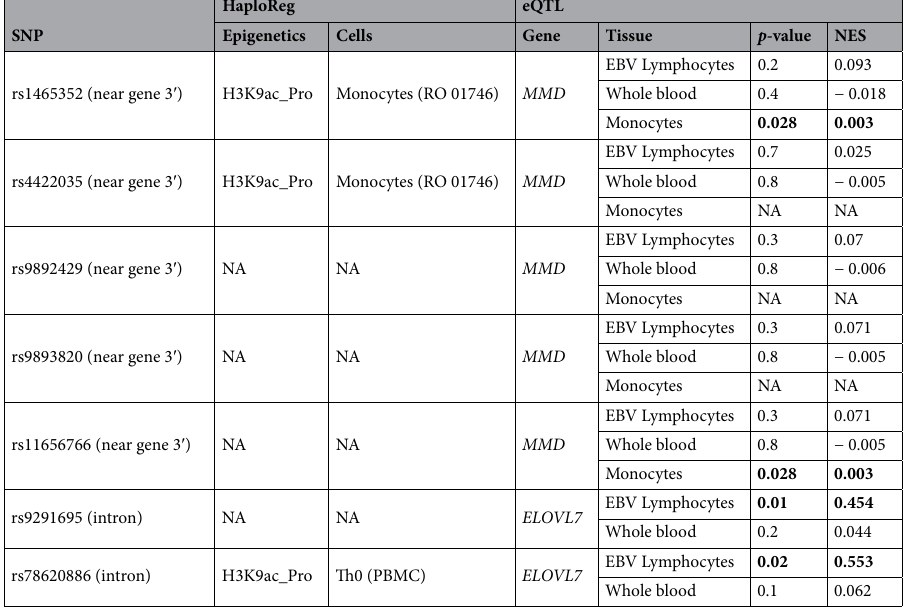
Table 4. Functional analysis of significant SNPs. NES Normalized effect size, NA not applicable, Bold text indicates statistically significant eQTLs.